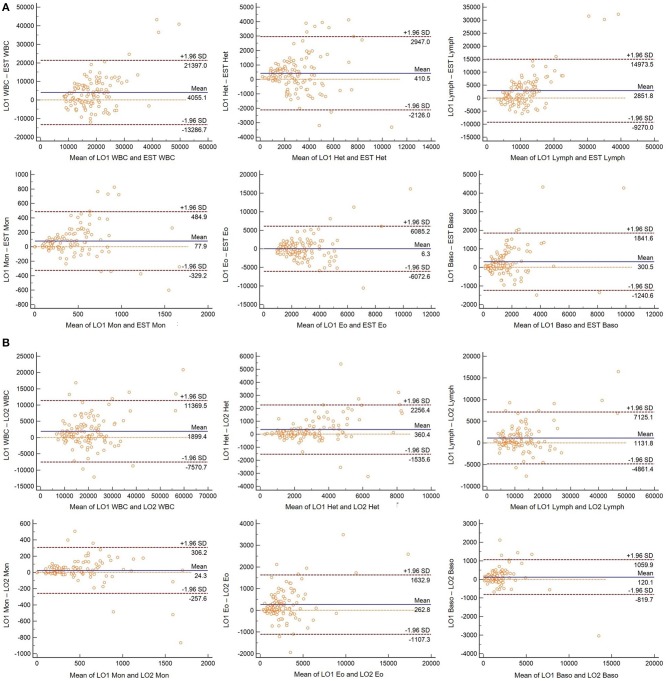
(A) Bland-Altman plots for hematology parameters determined using the Avian Leukopet method from one observer (LO1) and the WBC estimation method (EST) in 120 free-living eastern box turtles (Terrapene carolina carolina). Central lines depict the mean difference between the two methods, upper and lower lines represent limits of agreement (LOA), defined as the mean difference ±1.96 times the standard deviation of the differences. (B) Bland-Altman plots for hematology parameters determined using the Avian Leukopet method from one observer (LO1) and a group of observers (LO2) in 120 free-living eastern box turtles (Terrapene carolina carolina). Central lines depict the mean difference between the two methods, upper and lower lines represent limits of agreement (LOA), defined as the mean difference ±1.96 times the standard deviation of the differences.